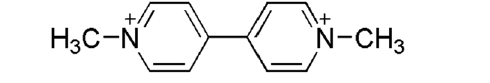
Fig. 1 Chemical structure of paraquat Table 1 Physical properties of paraquat CAS